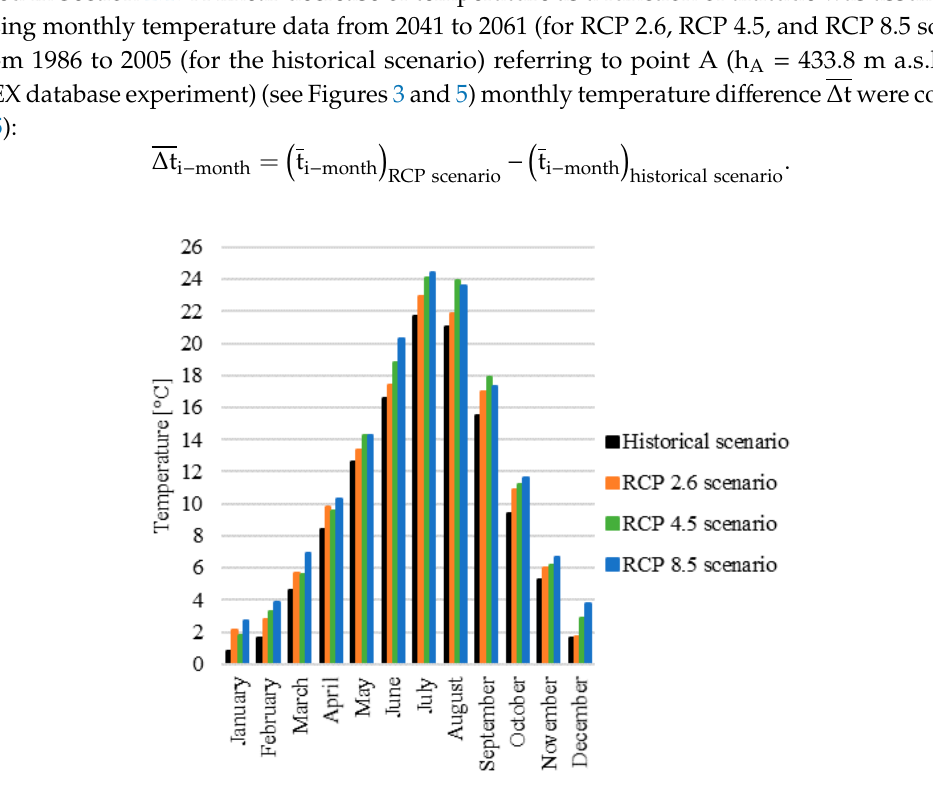
Figure 5. Mean monthly temperature at point A provided by the CORDEX experiment.